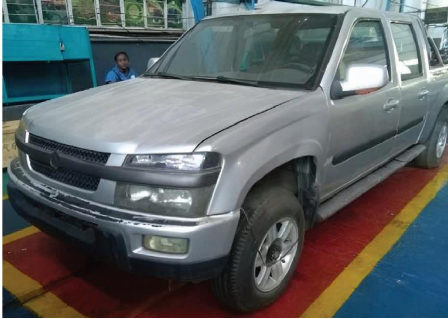
Figure 1: Bishoftu pickup